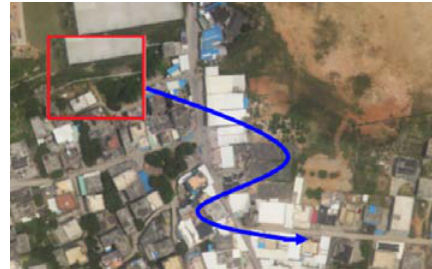
Fig. 5. Block matching in